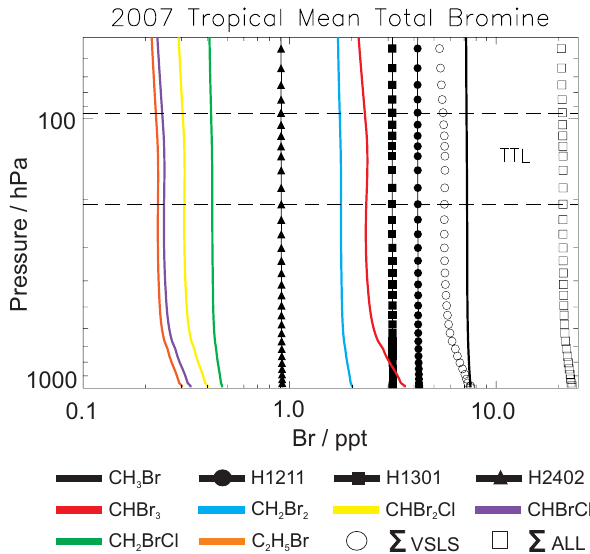
Fig. 6. Modelled tropical mean total bromine (ppt) for 2007 and from simulation S archived . Dashed horizontal lines denote the ap- proximate base of the TTL and the cold-point tropopause